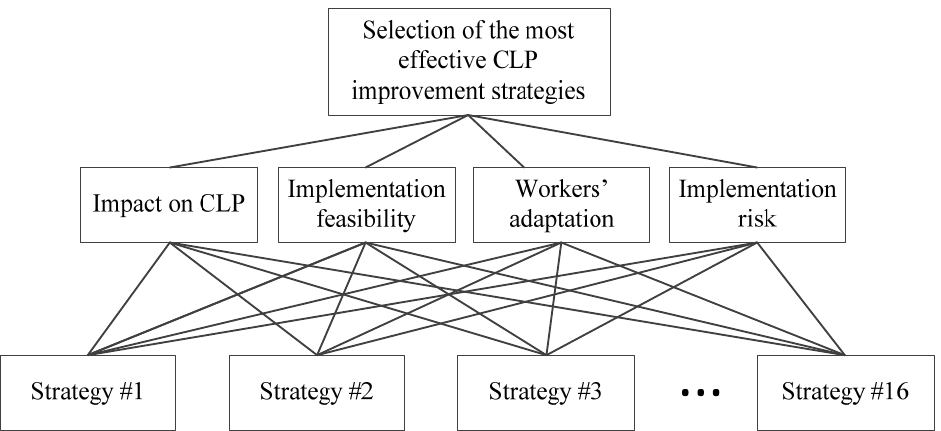
Figure 2. Hierarchical structure of decision making in improvement strategy selection.